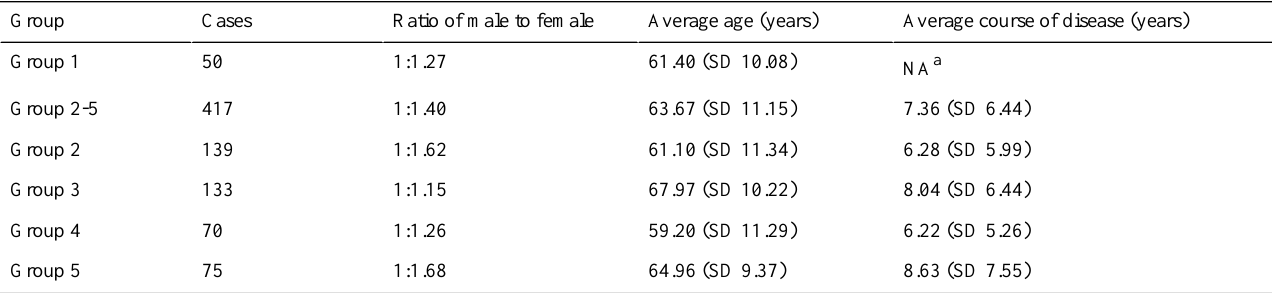
Table 1. Summary of demographics and clinic characteristics of each group.